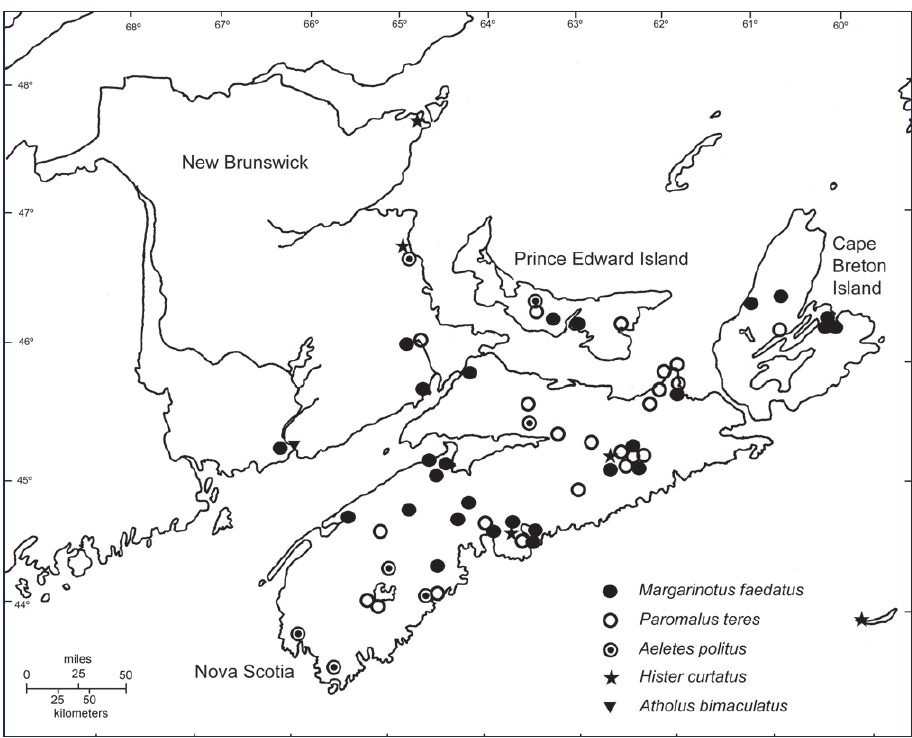
Fig. 1. Th e distribution of Margarinotus faedatus, Paromalus teres, Aeletes politus, Hister curtatus, and Atho- lus bimaculatus in Atlantic